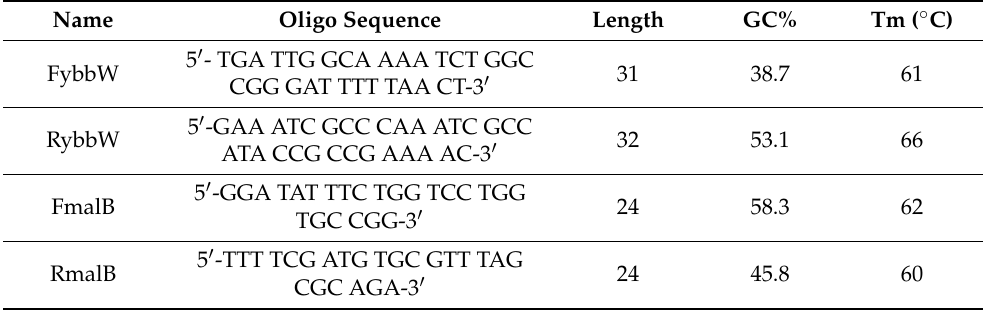
Table 1. Primers designed in this